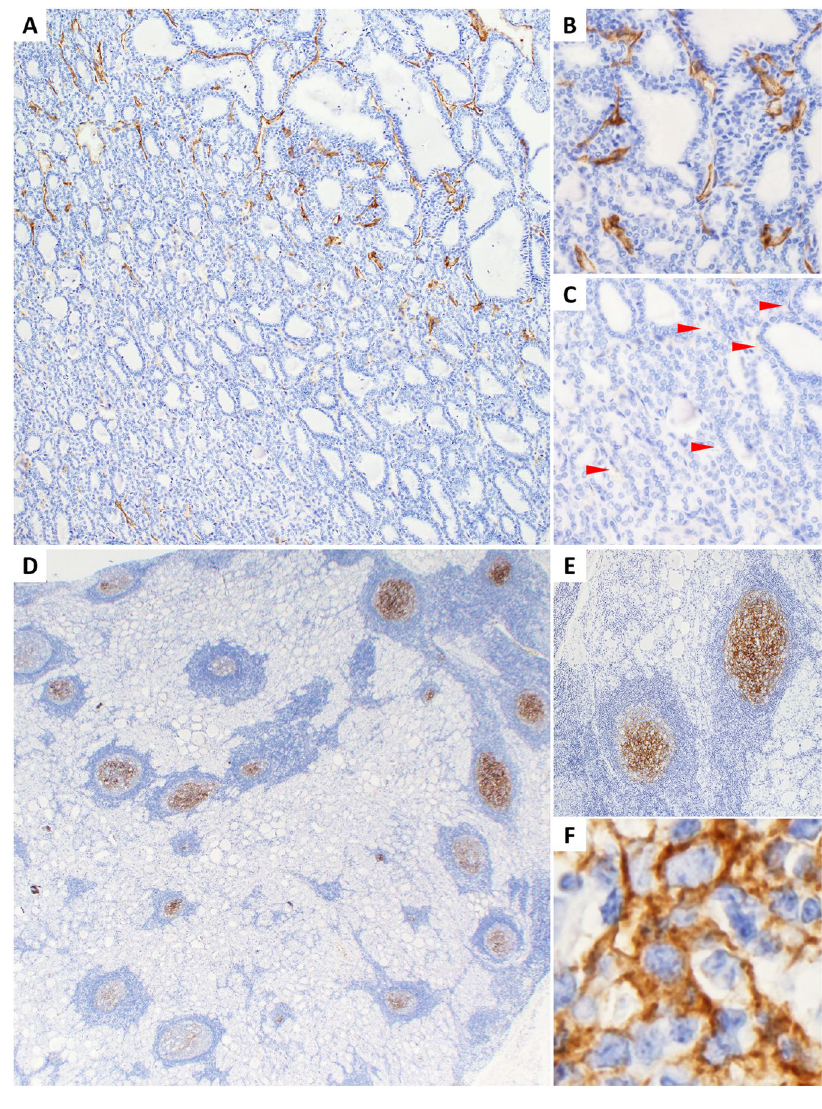
Figure 2. Potential imaging pitfalls associated with PSMA expression in thyroid lesions. ( A ) Significant heterogeneity within follicular carcinoma. Two neighboring areas with high ( B ) and negative ( C ) PSMA expression in tumor capillaries. Arrowheads indicate PSMA-negative microvessels. ( D ) Hashimoto’s thyroiditis with prominent PSMA immunoreactivity in lymphoid follicles ( E ) due to cytoplasmic staining of dendritic cells ( F ). Note absence of PSMA-positive endothelium. Immunohistochemistry, 100 × ( A , E ), 400 × ( B , C ), 20 × ( D ), 800 × ( F